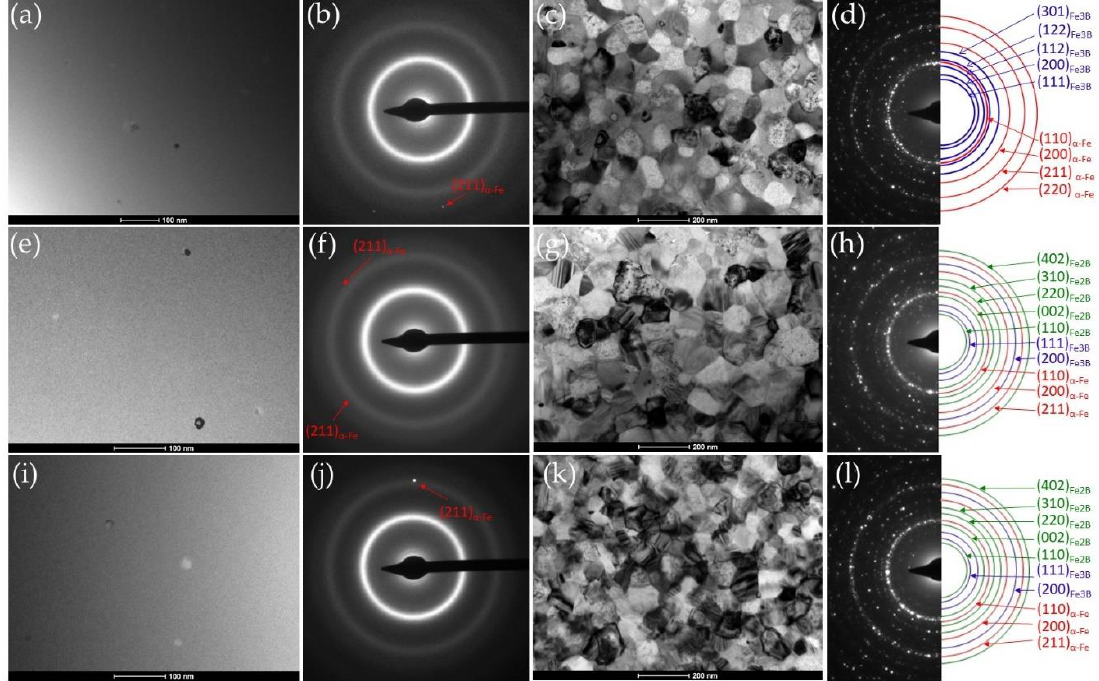
Figure 8. TEM images of annealed at temperatures at optimal P 10 / 50 values and full-crystalized samples: Fe 86 B 14 at 290 ◦ C bright-field (BF) ( a ), selected area di ff raction patterns (SADP) ( b ) and at 370 ◦ C BF ( c ), SADP ( d ); Fe 85.45 Cu 0.55 B 14 at 280 ◦ C BF ( e ), SADP ( f ) and at 370 ◦ C BF ( g ), SADP ( h ); Fe 85 Cu 1 B 14 at 300 ◦ C BF ( i ), SADP ( j ) and at 370 ◦ C BF ( k ), SADP ( l